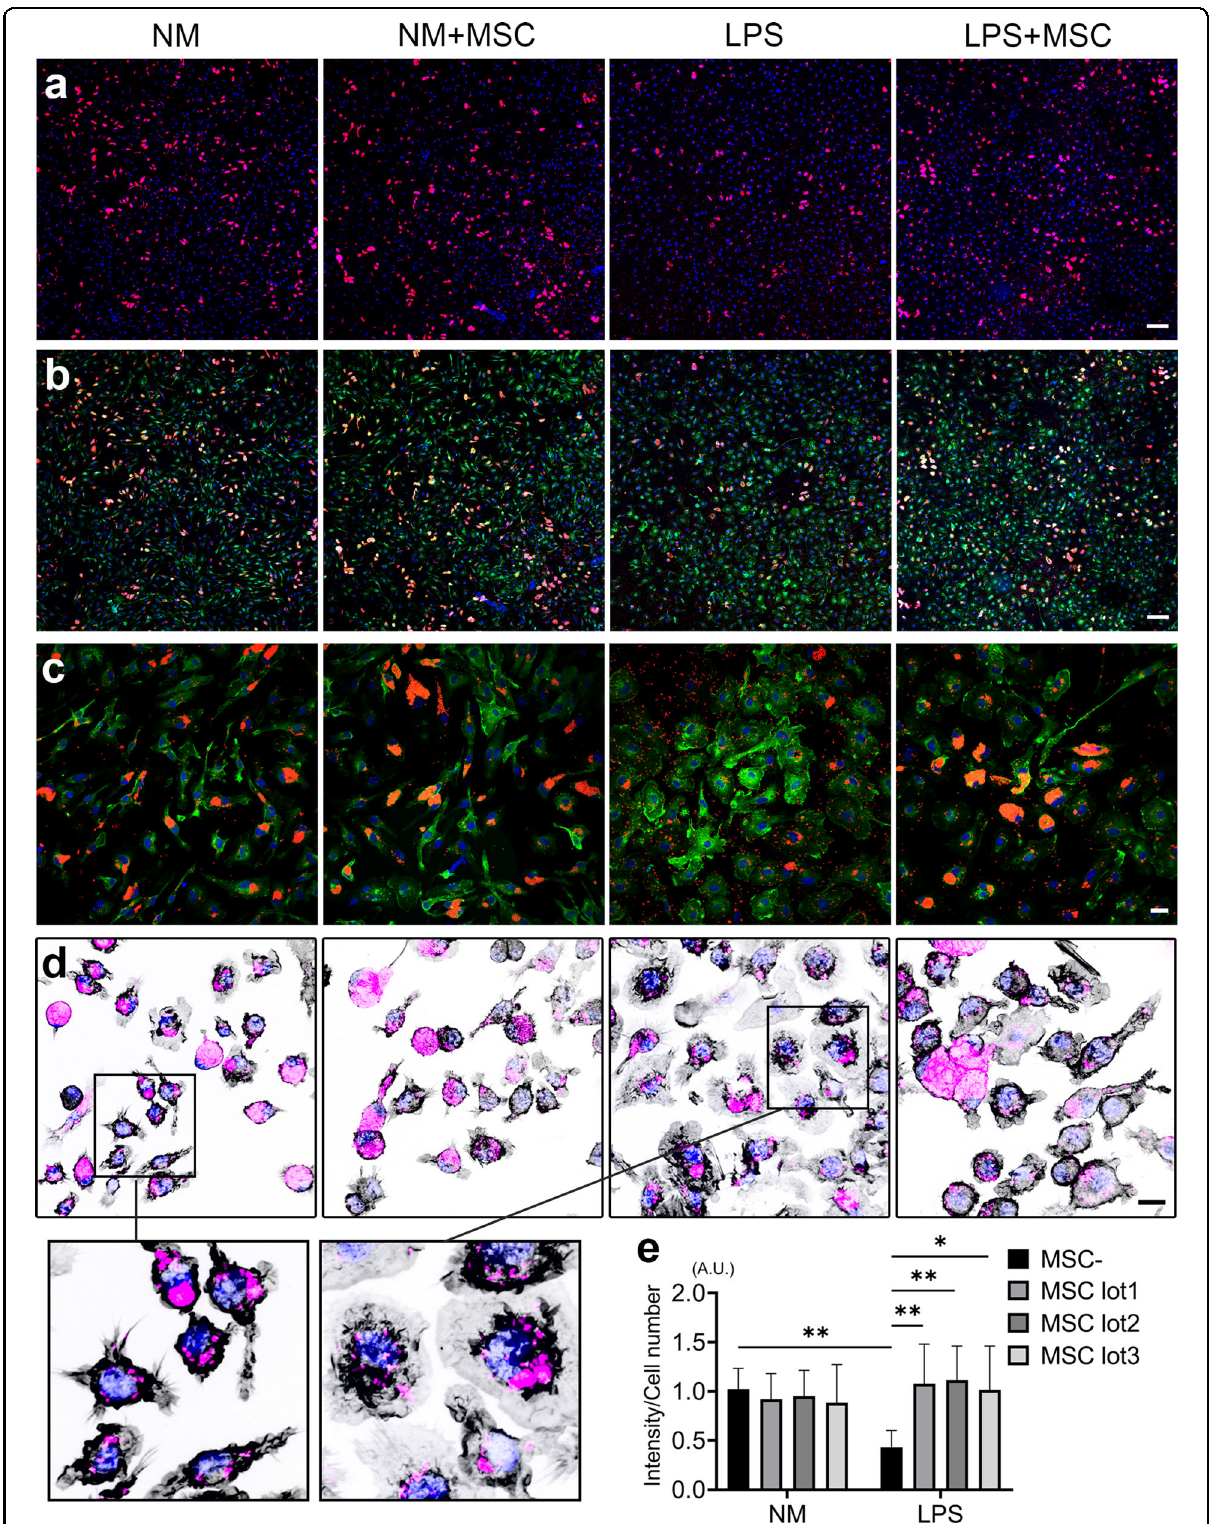
Fig. 4 Co-culture with MSC enhance phagocytosis in LPS activated microglia. Immunocytochemistry of E. coli bioparticles (red) and Hoechst 33342 (blue) ( a ), and merge with EYFP (green) ( b ) (scale bar = 100 μ m). High power fi eld of Fig. 4b ( c ) (scale bar = 20 μ m). F-Actin (black), E. coli bioparticles (red) and Hoechst 33342 (blue) ( d ) (scale bar = 20 μ m). Quanti fi cation of phagocytosis (Dunn ’ s multiple comparisons test was used). Data are presented as mean ± SEM with ** p < 0.01, * p < 0.05 ( e ). Abbreviation: A.U., arbitrary